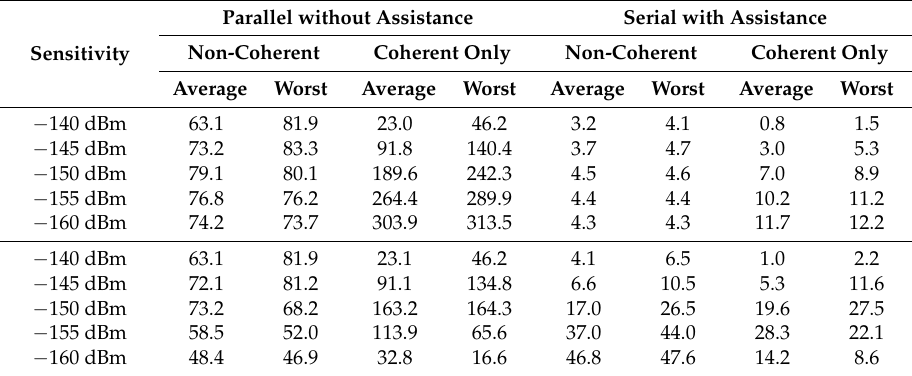
Table 12. Final ratio of complexity (product of processing time ratio, memory ratio and frequency bins ratio) between the L5 and L1 C/A signals obtained as the product of Tables 10 and 11. Top rows do not